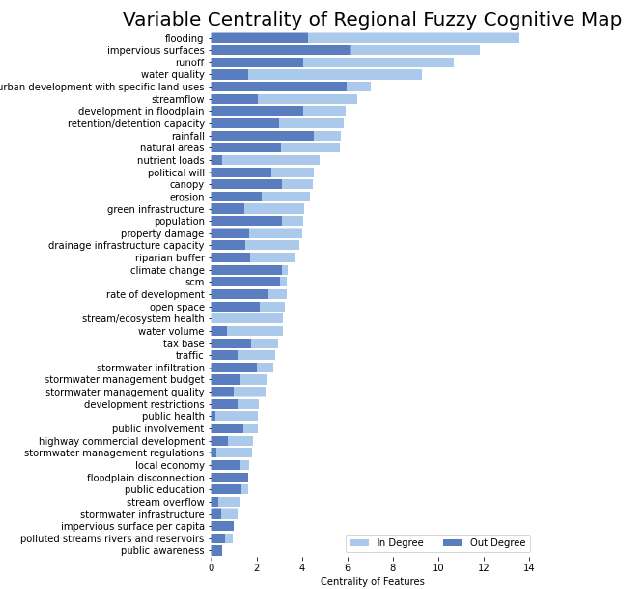
Figure 7. Flooding is the most central feature found in the regional FCM. Impervious surface and urban development influence other variables the most, as evident by their out-degree, and flooding and water quality are the most influenced